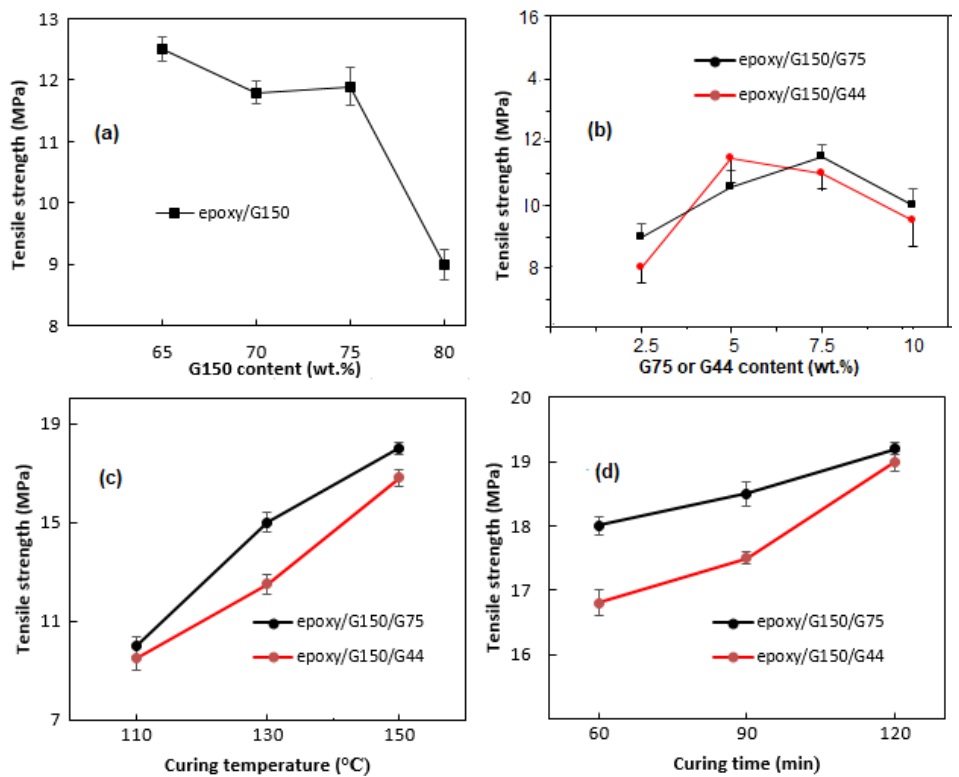
Figure 6. The tensile strength values of epoxy/G composites: ( a ) epoxy/G150 prepared at 110 °C, 60 min; ( b ) epoxy/70% G150/G75 and epoxy/70% G150/G44 prepared at 110 °C, 60 min; ( c ) epoxy/70 wt.% G150/10 wt.% (G44 or G75) prepared at 60 min and different curing temperatures; ( d ) epoxy/70 wt.% G150/10 wt.% (G44 or G75) prepared at 051 °C and different curing times.